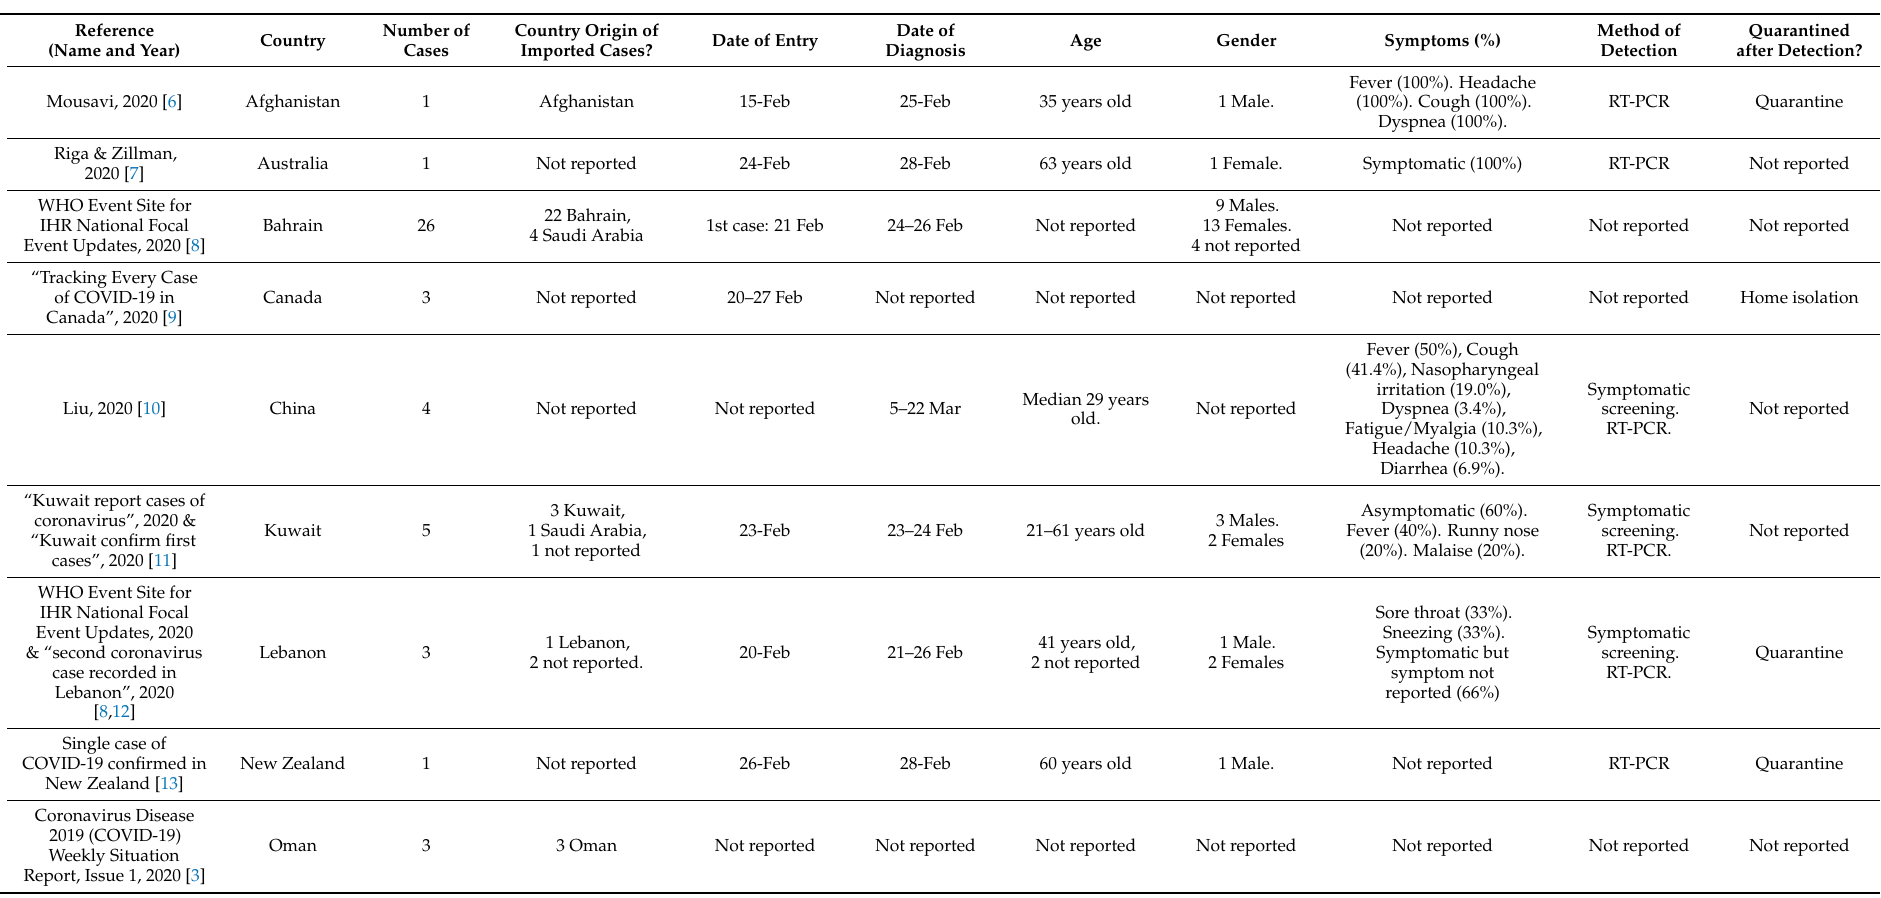
Table 1. Summary of cases imported from